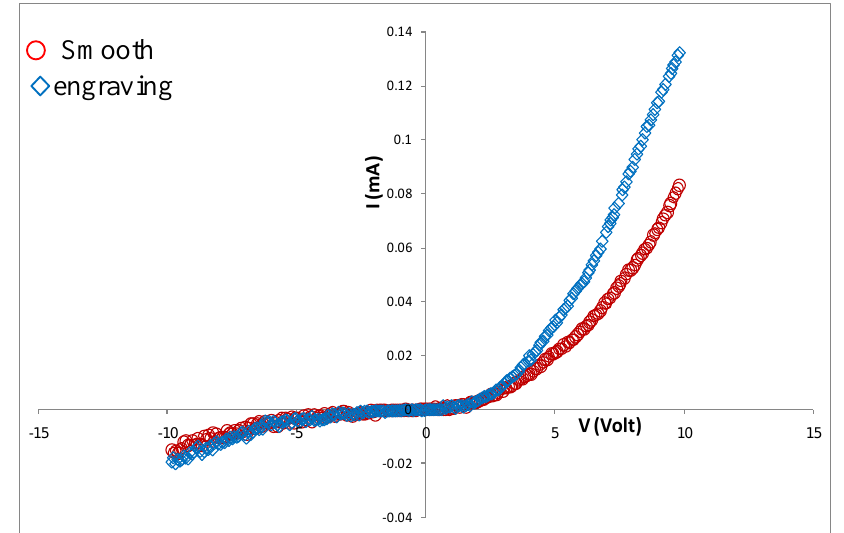
/n-Si detector in the 2